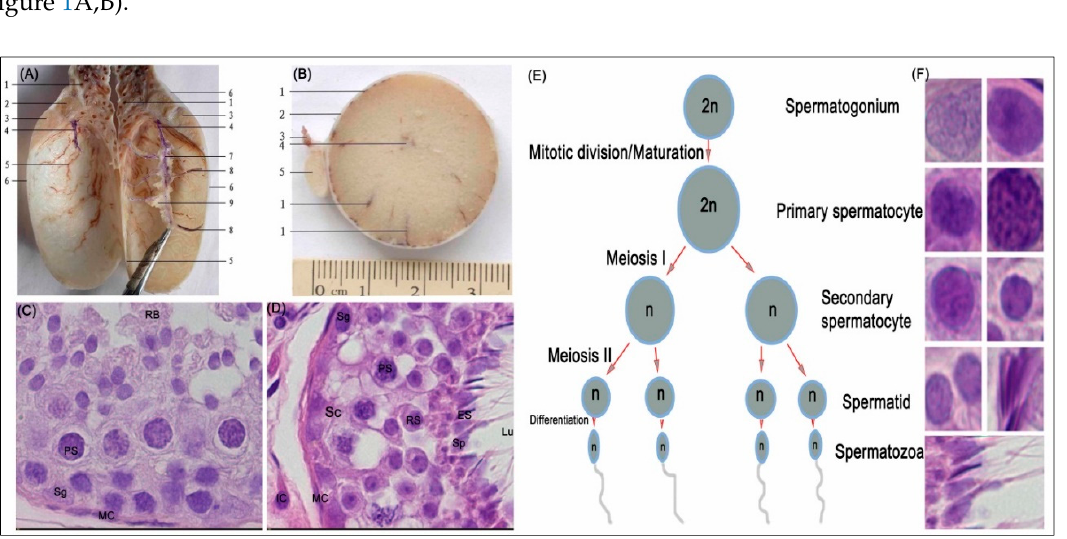
Figure 1. Morphologic and histologic study: ( A ) testis of yak longitudinally cut and without parenchyma testis; 1, pampiniform plexus; 2, head of epididymis; 3, epididymis; 4, efferent ductules; 5, vein; 6, tunica albuginea; 7, mediastinum testis; 8, arteries; 9, parenchyma testis. ( B ) Testis of yak (intersect), 1, blood vessel; 2, tunica albuginea; 3, ductus deferens; 4, mediastinum testis; 5, epididymis. ( C , D ) Representative haematoxylin & eosin (H&E) stained seminiferous epithelium section of yak testes (×1000), ( E ) stages in spermatogenesis; ( F ) representative structures of spermatogenesis in the yak testes. Lu, lumen; Sc, Sertoli cell; PS, primary spermatocyte; ES, Elongated spermatid, MC, myoid cells, RB, round body; Sg, Spermatogonia; RS, Round spermatid; Sp, Spermatozoa; IC, Interstitial cell.